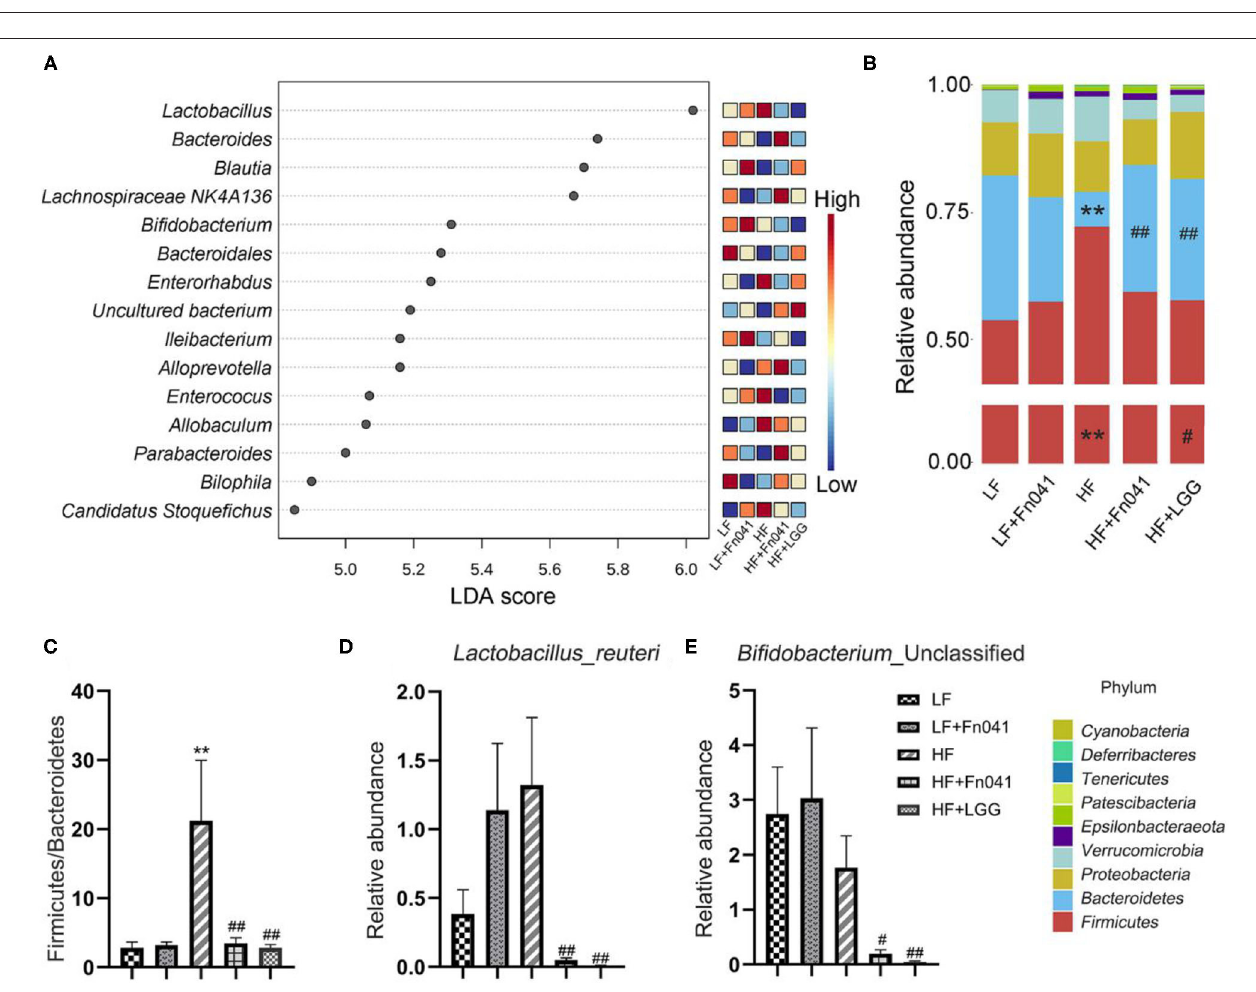
FIGURE 6 | Effect of Lactobacillus reuteri Fn041 on structural changes in the gut microbiota. (A) LDA combined with effect size measurements (LEfSe) at the genus level. Data with an FDR < 0.05 and an LDA score ≥ 4.0 were considered significant in Kruskal–Wallis; (B) The bacterial profiles at the phylum level (each color represents one phylum); (C) The ratio of Bacteroidetes to Firmicutes ; (D) Levels of L. reuteri ; (E) Levels of Bifidobacteria _ Unclassified. ( n = 8/group). ** p < 0.01 as compared with the LF group; # p < 0.05, ## p < 0.01 as compared with the HF group. LF, low-fat diet group; LF, low-fat diet group; LF + Fn041, low-fat diet group treated with L. reuteri Fn041; HF, high-fat diet group; HF + Fn041, high-fat diet group treated with L. reuteri Fn041; HF + LGG, high-fat diet group treated with Lactobacillus rhamnosus